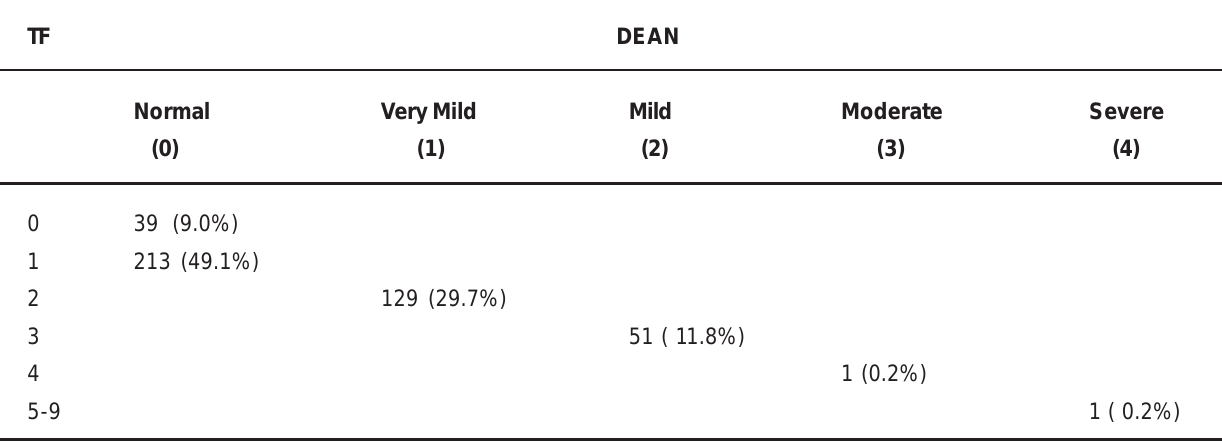
TABLE 4 -Comparison between the TF outcomes and Dean index in children attending basic health units in Londrina,